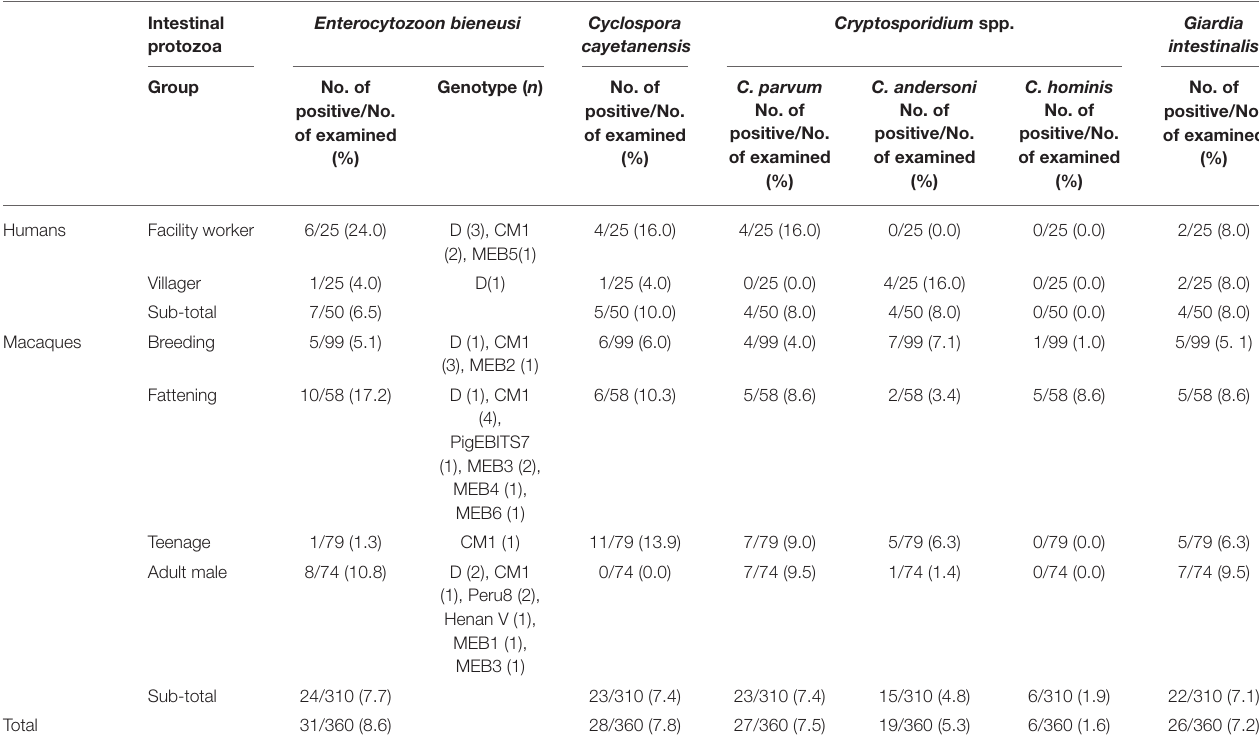
TABLE 1 | Occurrence of Enterocytozoon bieneusi , Cyclospora cayetanensis , Cryptosporidium spp., and Giardia duodenalis in humans and macaques. Intestinal protozoa